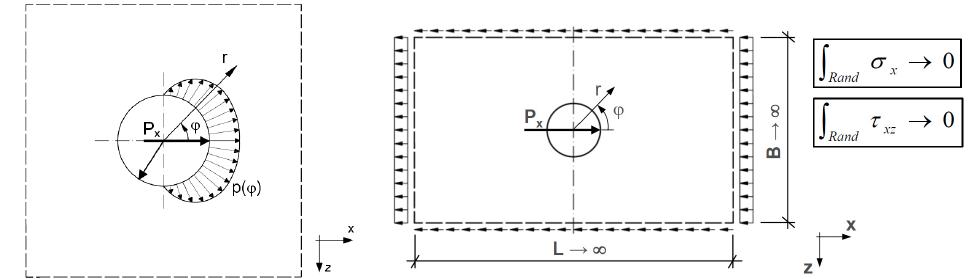
Figure 4a and b: Stress distribution caused by bolt load and equilibrium of a drilled pane, loaded by bolt